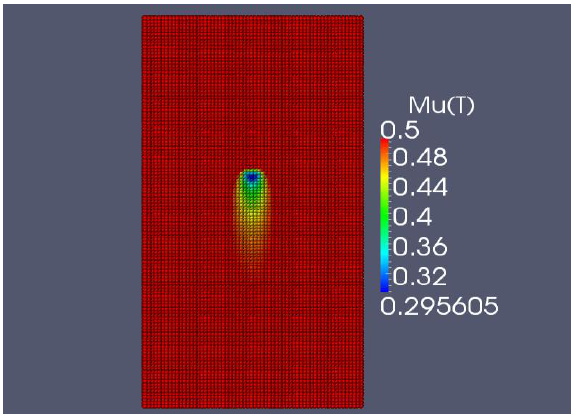
Figure 11. μ ( T ) results from FDM simulation at optimal parameters, t = 23 k